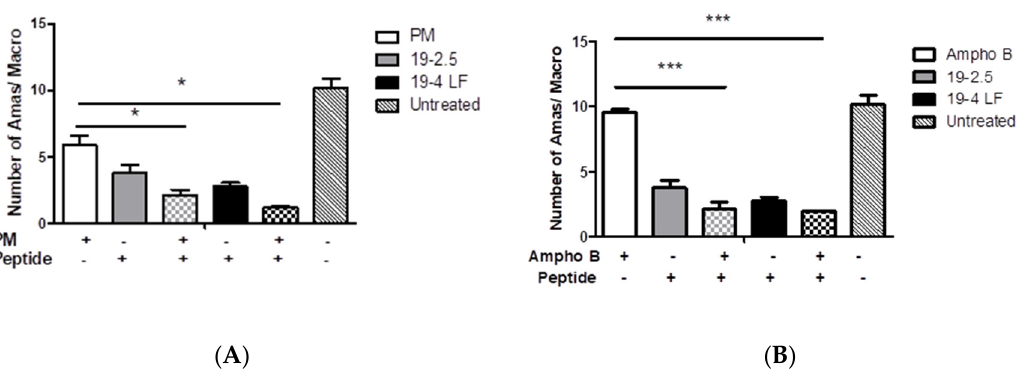
Figure 7. Leishmanicidal effect of PM (50 µM) ( A ), Ampho B (0.025 µM) ( B ) and their combinations with peptides Pep19-2.5 (1 µg/mL) and Pep19-4 LF (1 µg/mL). Bars represent the means (±SD) from three independent experiments (*, p < 0.05; ***, p <